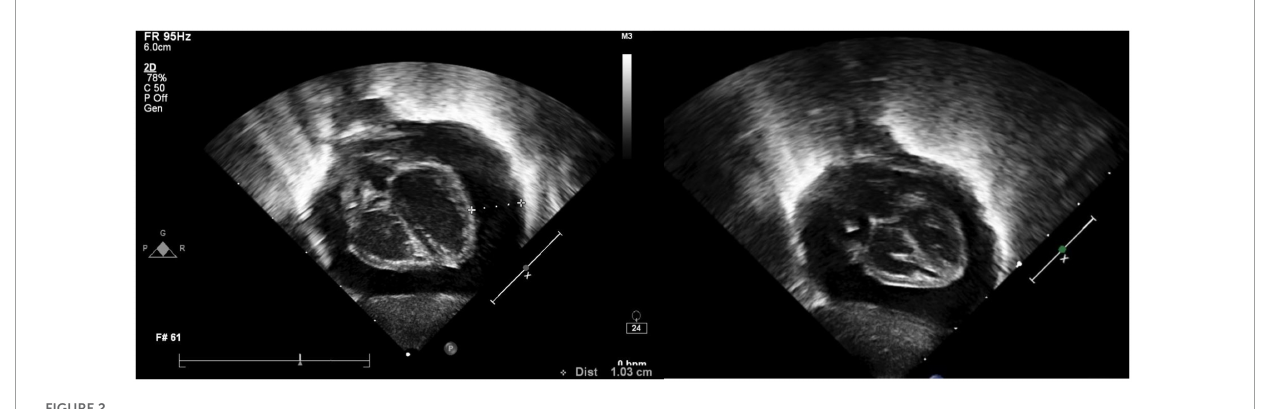
FIGURE2 Echocardiogram showing cardiac tamponade of Case